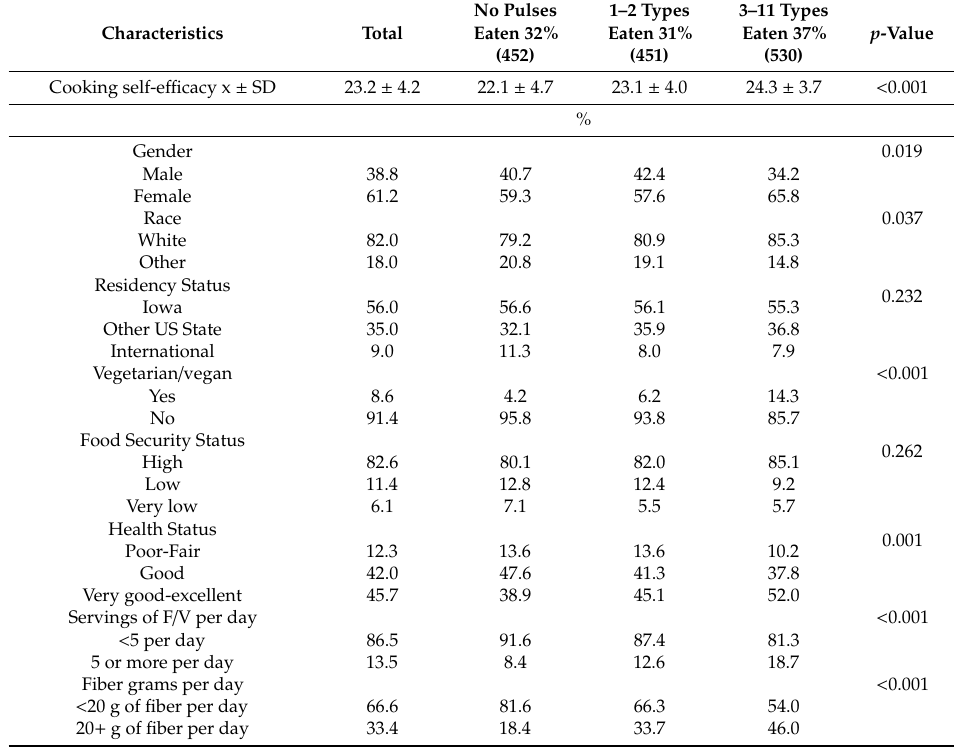
Table 2. Demographic and health characteristics of students enrolled at a Midwestern US university by trivariate pulse type count eaten per month (%; n =